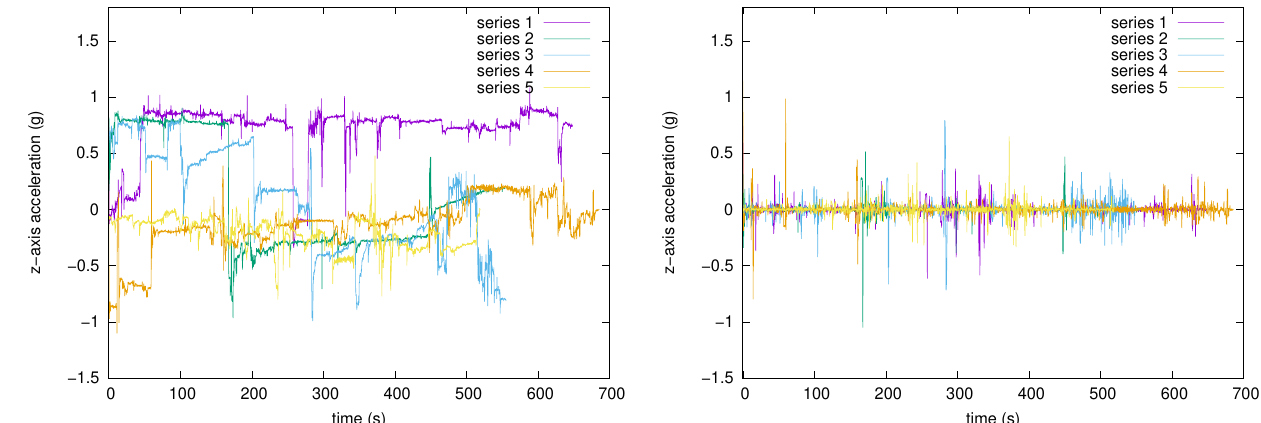
Figure 6. Z -axis acceleration data from subject 2, recorded while resting. Original data ( left panel ), and after mean-value subtraction ( right panel ), using non-overlapping windows of 1200